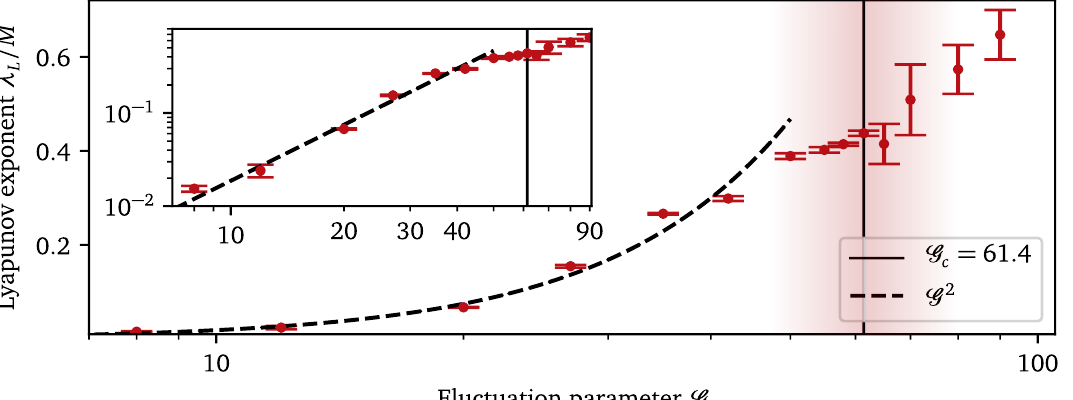
Figure 4: Lyapunov exponent. The Lyapunov exponent λ of G , with a different approach to the phase transition from above and below. The red shading indicates the range of G in which critical slowing down was found in the spectral function. An approximate power-law behaviour (see inset). Error bars are statistical errors obtained from a jackknife binning analysis detailed in App.